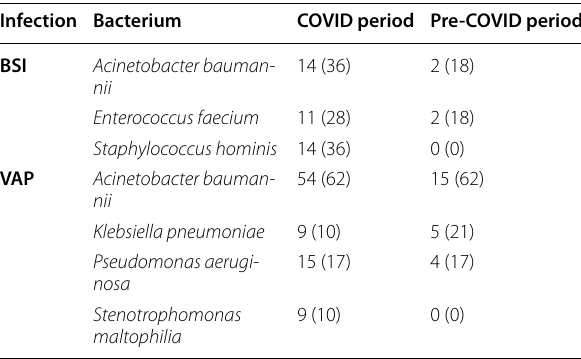
Table 2 Isolated pathogens associated with specific